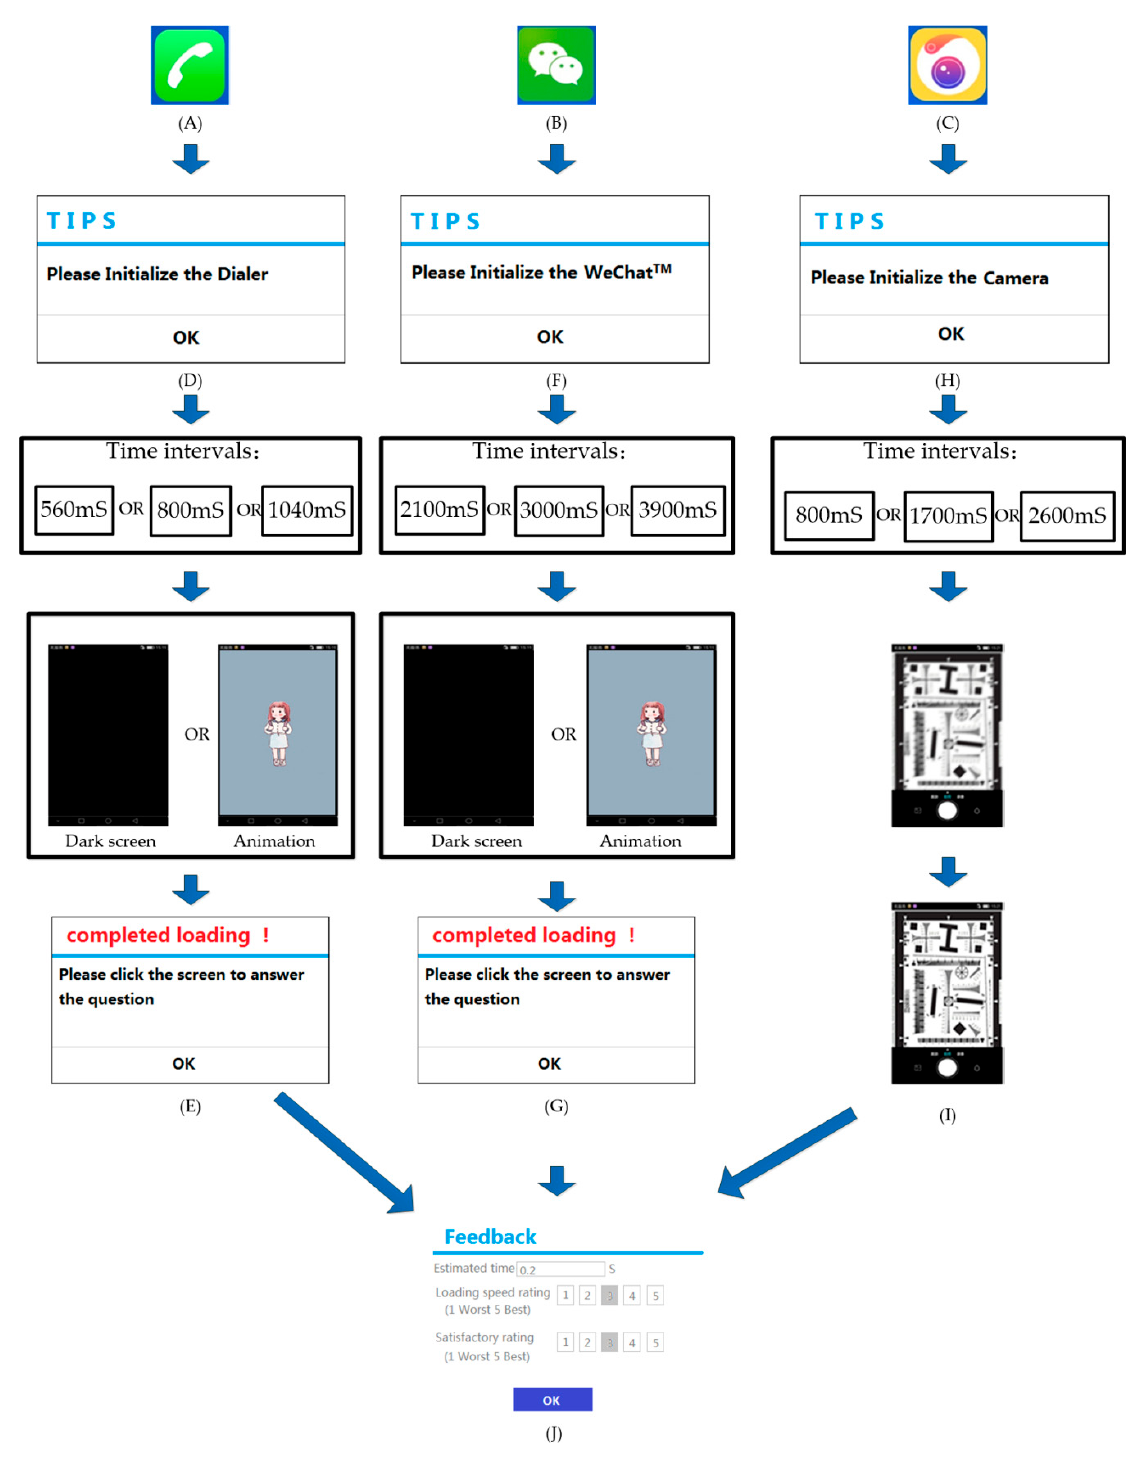
Figure 3. The high-fidelity models to mimic the human-machine interaction icons of the three modes. From left to right: ( A ) dialer, ( B ) WeChat TM and ( C ) camera, ( D ) pop-up message to indicate the initialization of the dialer, ( E ) pop-up message to indicate the completion of the loading process for the dialer, ( F ) pop-up message to indicate the initialization of WeChat TM , ( G ) pop-up message to indicate the completion of the loading process for WeChat TM , ( H ) pop-up message to indicate the initialization of camera, ( I ) pop-up message to indicate the completion of the loading process for camera and ( J ) questionnaire to score for the response time as well as the loading process.